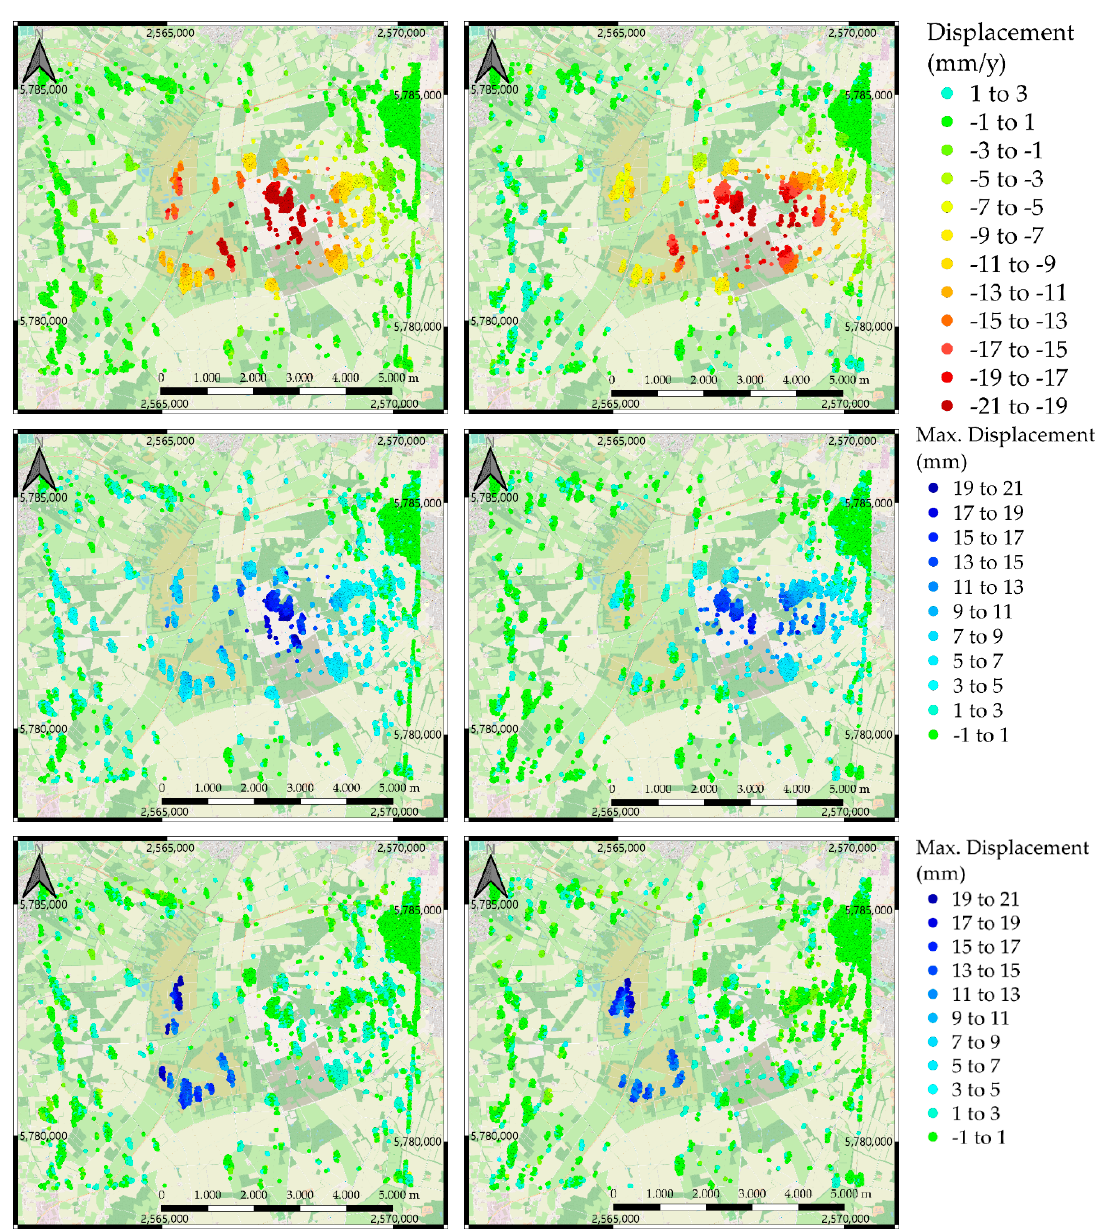
Figure 5. Estimated parameters in line of sight. On the left from ascending orbit, on the right from descending orbit. From first row to third row: linear rate, pressure response, seasonal displacement. The brownish color surrounding the points with strongest seasonal displacement displays the fen.